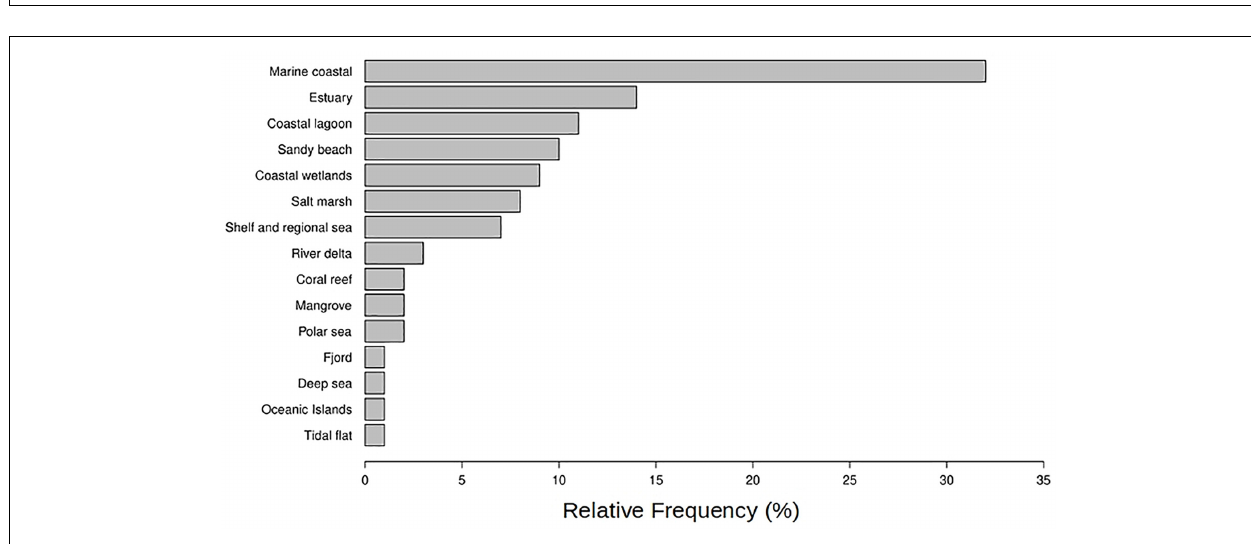
FIGURE 2 | The diversity of habitats represented at coastal and marine International Long-Term Ecological Research